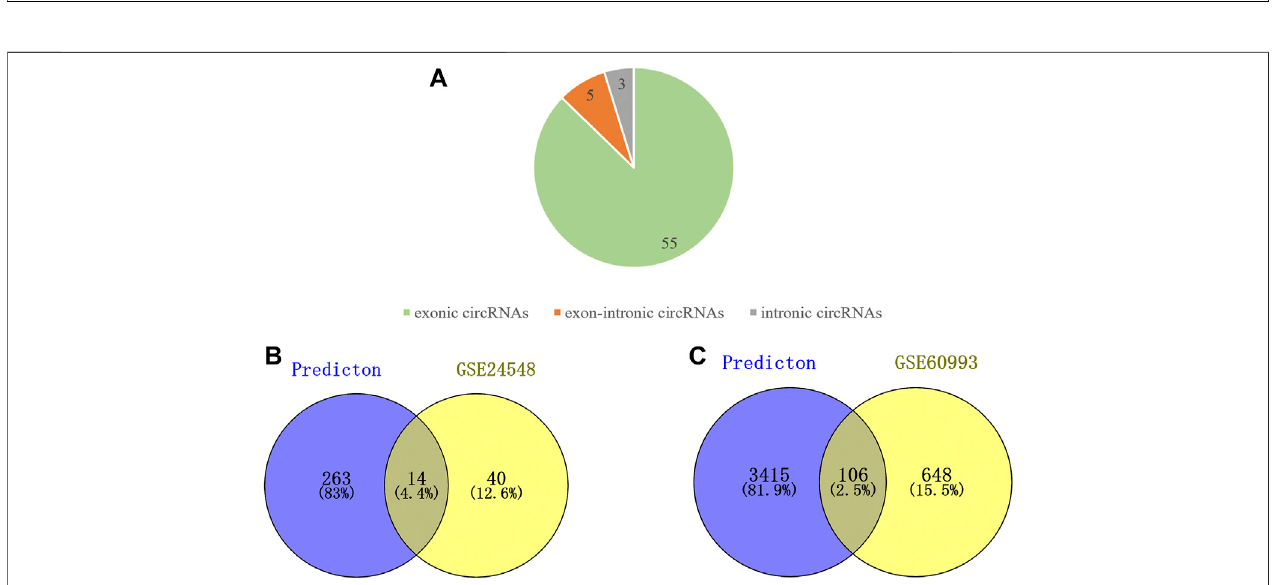
FIGURE 2 | Analyze the type of DEcircRNAs and predict miRNAs downstream of DEcircRNAs as well as the mRNAs downstream of DEmiRNAs. (A) Type of the DEcircRNAs, including 55 exonic circRNAs, 3 exon-intronic circRNAs, and 3 intronic circRNAs. (B) Venn diagram of DEmiRNA intersection with miRNA predicted by DEcircRNA. (C) Venn diagram of DEmRNA intersection with mRNA predicted by DEmiRNA.